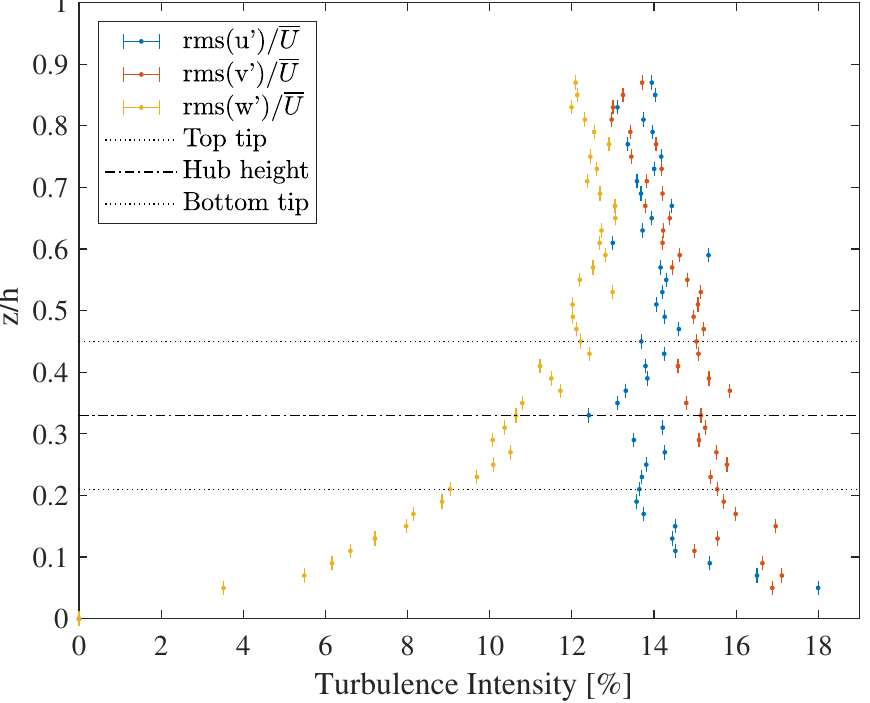
Figure 3. Turbulence intensity profiles in the freestream flow measured by ADV. Error bars indicate the 95% confidence interval (see Section